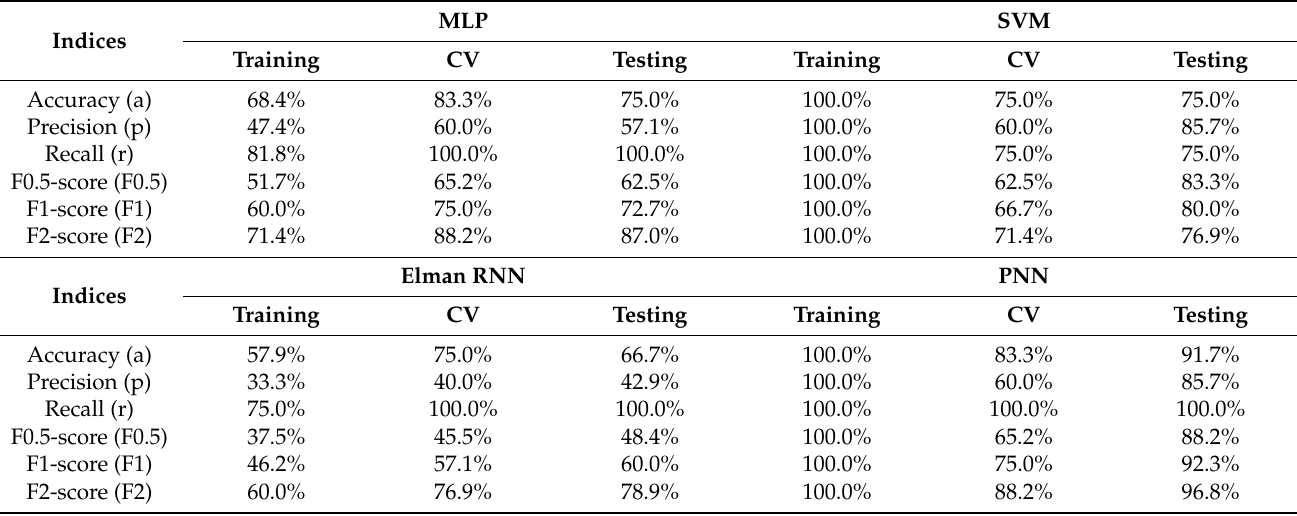
Table 6. Model performance of MLP, SVM, Elman RNN and PNN